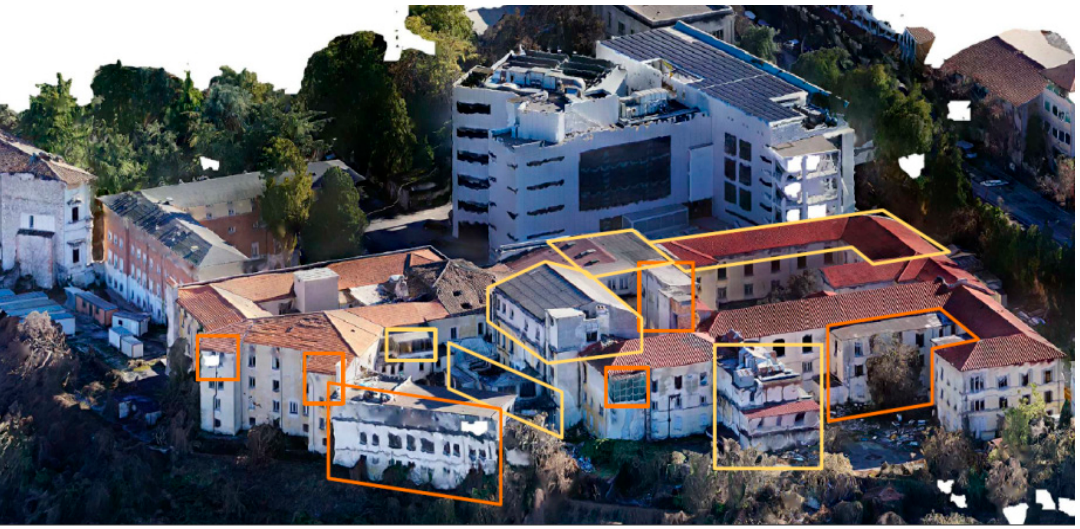
Figure 8. Identification of inadequate additions (yellow outlines) or design incongruity (orange outlines) that have to be demolished: the technologies used for the investigations allowed to carry out highly detailed studies on volumes, in order to accurately determine the configuration of the building for the project initial phase.